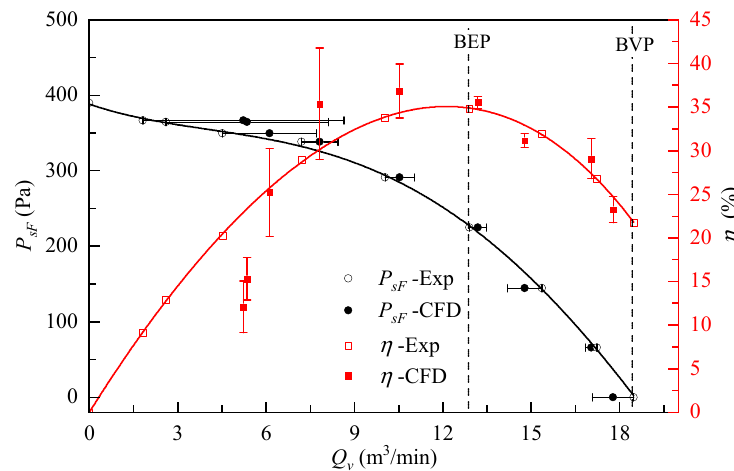
Figure 8. Comparison of the CFD and experimental.